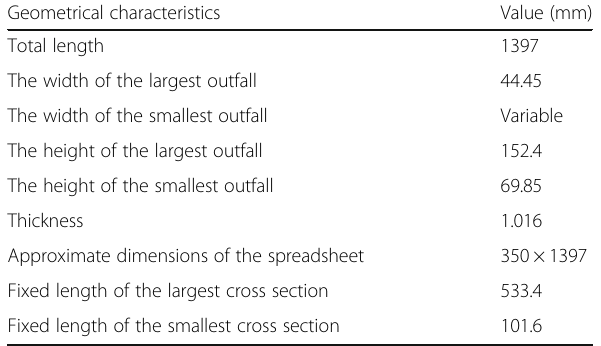
Table 3 Point-to-point characteristics of the cross-section B-B